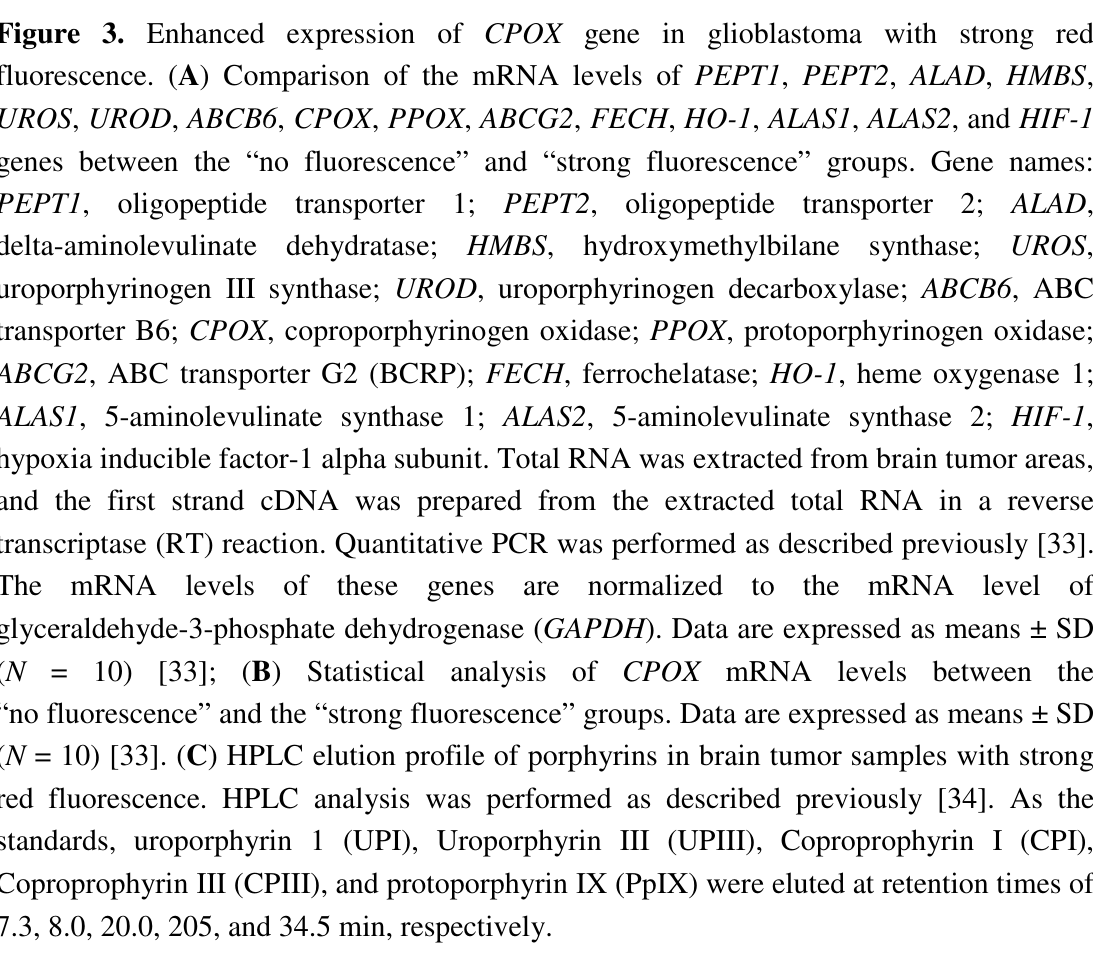
Figure 3. Enhanced expression of CPOX gene in glioblastoma with strong red fluorescence. ( A ) Comparison of the mRNA levels of PEPT1 , PEPT2 , ALAD , HMBS , UROS , UROD , ABCB6 , CPOX , PPOX , ABCG2 , FECH , HO-1 , ALAS1 , ALAS2 , and